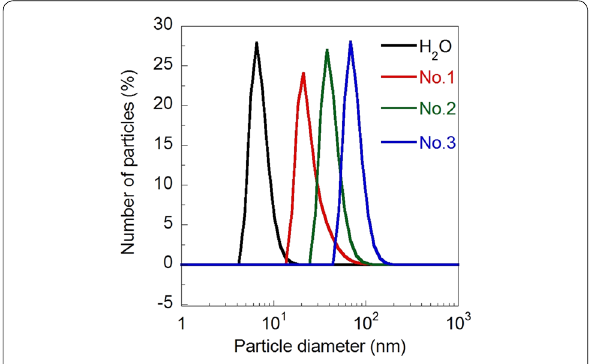
Fig. 3 Number‑distributions of hydrodynamic diameter for ZnO nanoparticles estimated with dynamic light scattering